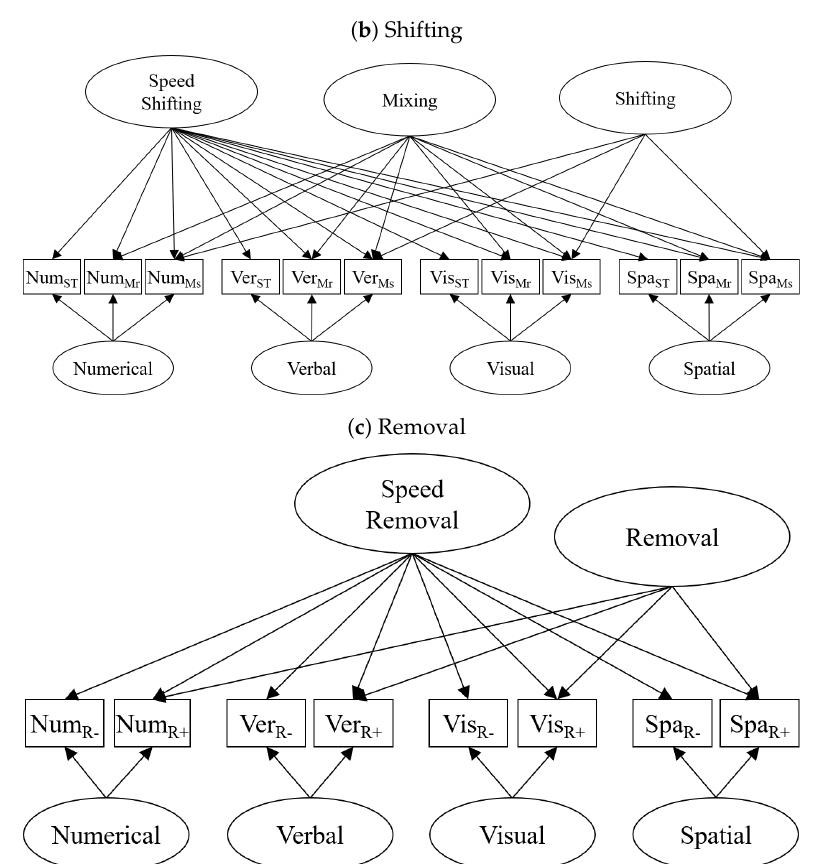
Figure 1. Simplified path diagrams of bi-factor models isolating condition specific individual differences from baseline processing speed in executive processing tasks. In addition, the models include specific factors that capture individual differences unique to a single task or a content domain. For inhibition and removal tasks, the + index refers to a condition strongly demanding the respective executive process, whereas an - index suggest that it demands it less. For the shifting tasks, single task (ST) performance was separated from performance in mixed blocks (M) for trials repeating the task of the previous trial (r) and trials switching to a different task than in the previous trial (s). Error variances were omitted in the figure to ease